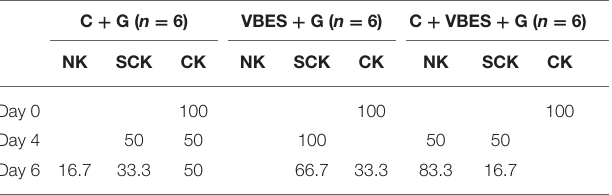
TABLE 4 | Percentage of ketotic types on pre-treatment day (Day 0), and on 1 day (Day 4) and 3 days (Day 6) after the last treatment